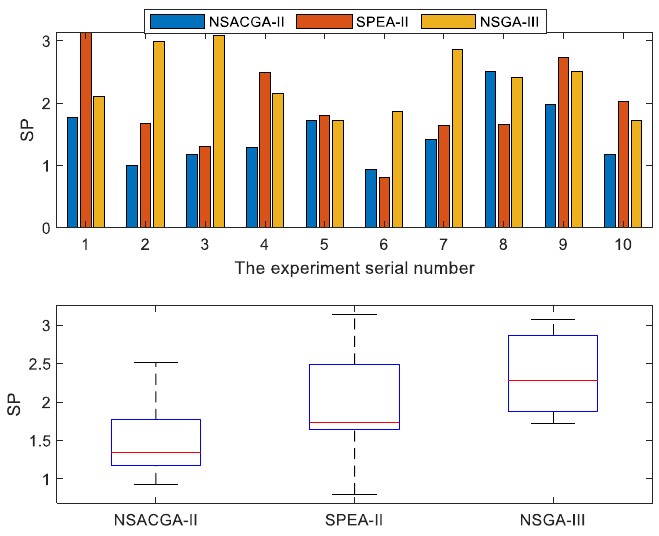
Figure 9. SP of NSACGA-II, SPEA-II and NSGA-III.